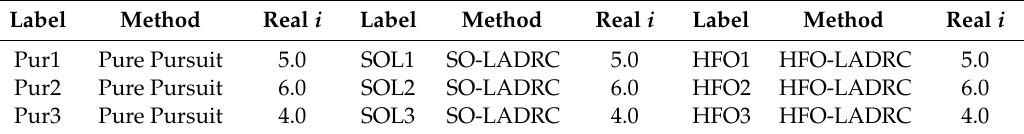
Table 3. Method and real steer ratio i